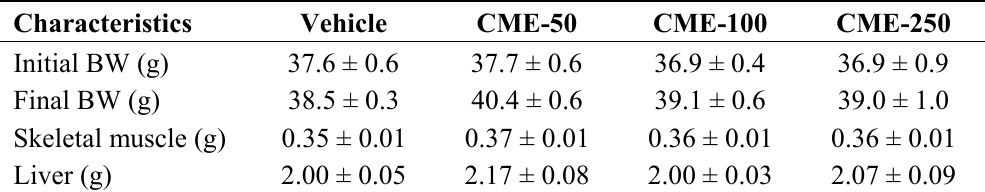
Table 1. General characteristics of the experimental